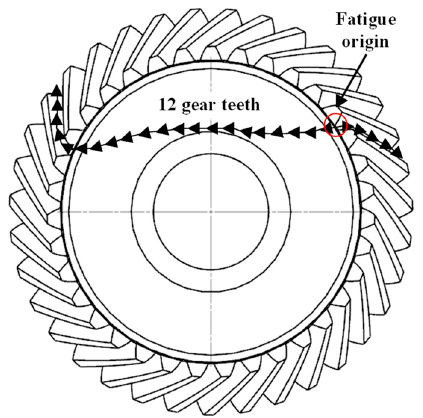
Figure 20. Schematic diagram of rupture failure of driven bevel gear.